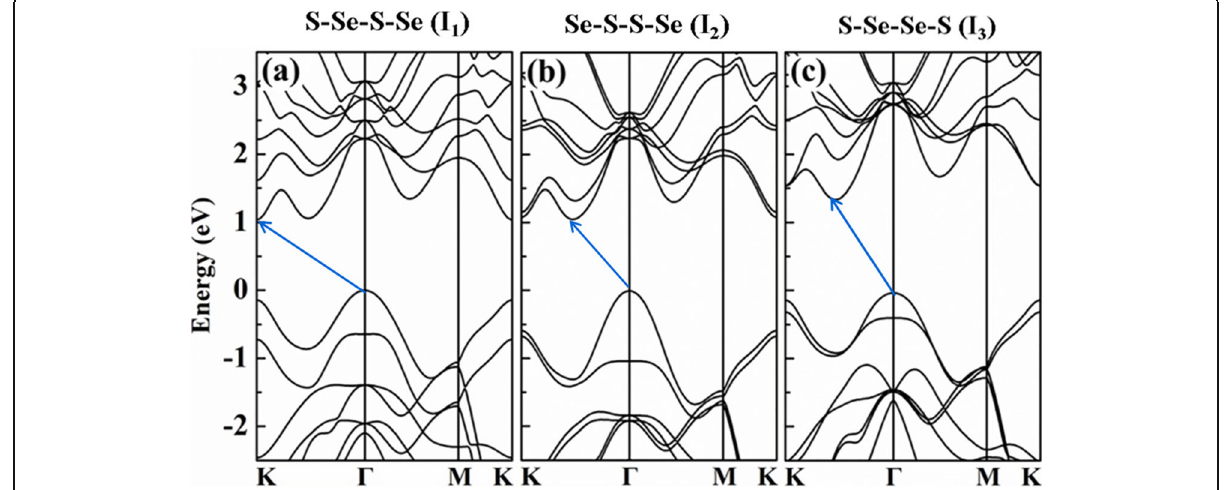
Fig. 3 Band structures of I 1 , I 2 , and I 3 , respectively, where the bandgaps are denoted by the blue